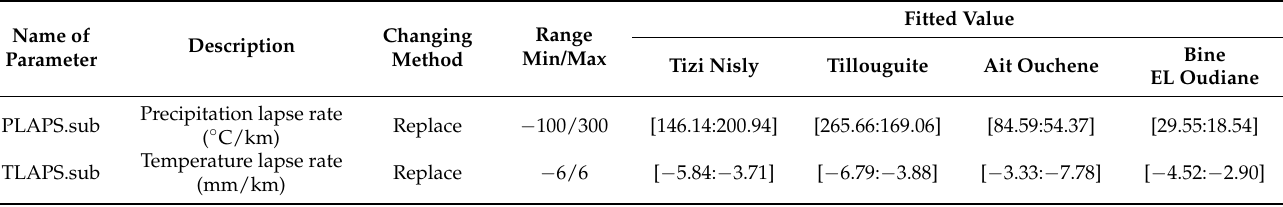
Table A1. Optimal values of lapse